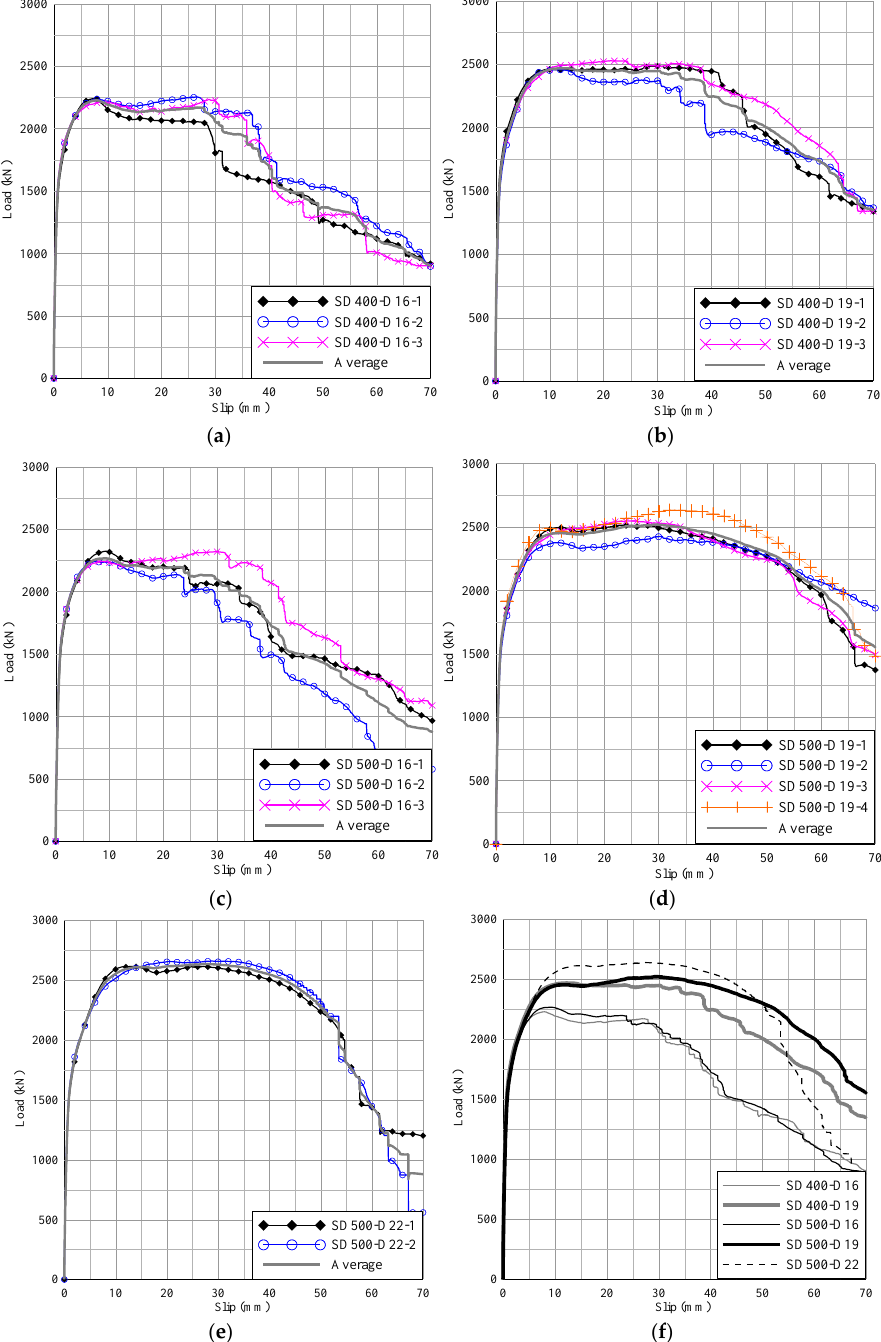
Figure 6. Load – slip curves for monotonic loading tests. ( a ) SD400-D16, ( b ) SD400-D19, ( c ) SD500-D16, ( d ) SD500-D19, ( e ) SD500-D22 and ( f ) averaged load – slip curves. Table 5. Test results of shear resistance and ductility.